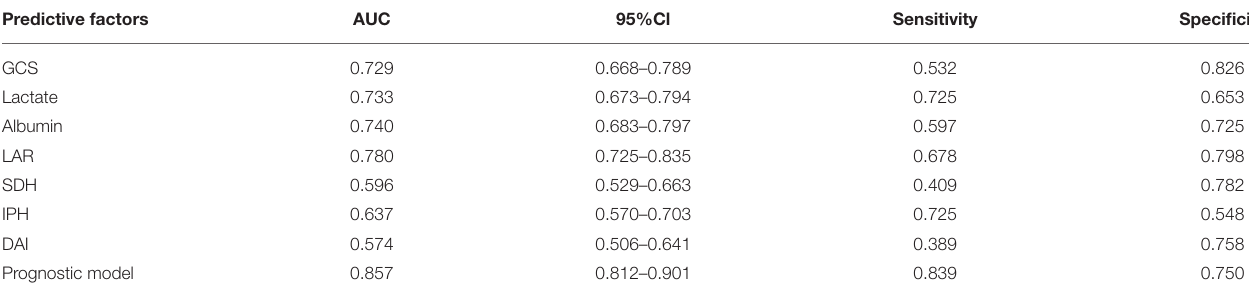
TABLE 4 | Value of factors and constructed prognostic model on predicting mortality in patients with moderate to severe TBI. Predictive